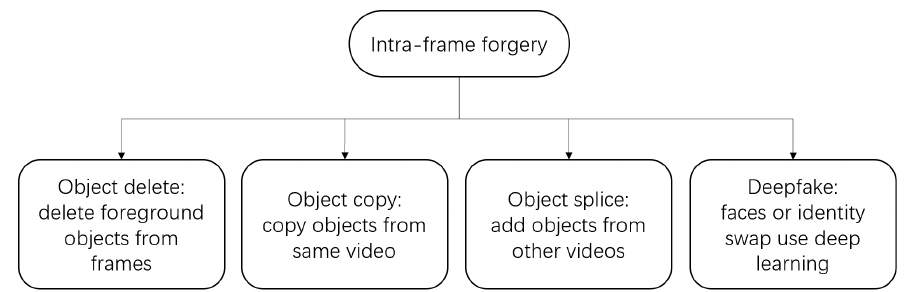
Figure 1. Description of different types of intra-frame tamper operations.